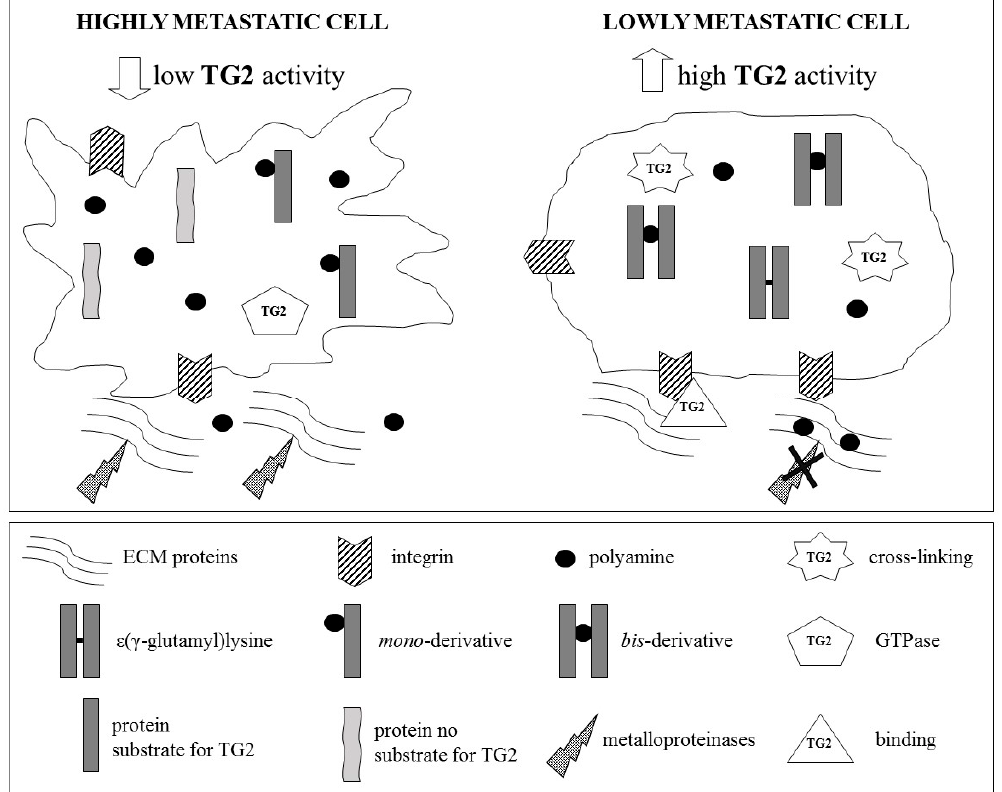
Figure 2. Tumor cells, with high metastatic potential, are characterized by high levels of intracellular polyamines and low transamidase activity of TG2. This condition favors the formation of mono-( γ -glutamyl) derivatives of polyamines, preventing polymerization of intracellular proteins, in particular, those components of the cytoskeleton. It follows that cellular plasticity is high, due to the reduction of cell–cell or cell–matrix interactions, which favors cell detachment and motility. By contrast, in cells with reduced metastaticity, the transamidase activity of TG2 is higher. Hence, the polymerization of intracellular proteins is increased by the favored formation of ε -( γ -glutamyl) lysine and bis-( γ -glutamyl) polyamine derivatives. Therefore, in these cells, the plasticity is reduced and the cell–matrix interactions, mediated by integrins and TG2, are more pronounced, due to the increase in cell adhesion with extracellular matrix (ECM) (modified from Lentini et al., 2013 [17]).